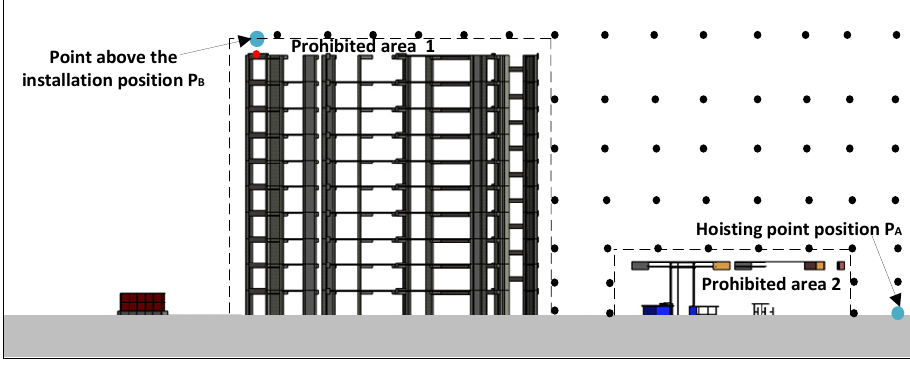
Figure 9. Hoisting topology diagram of PCs.